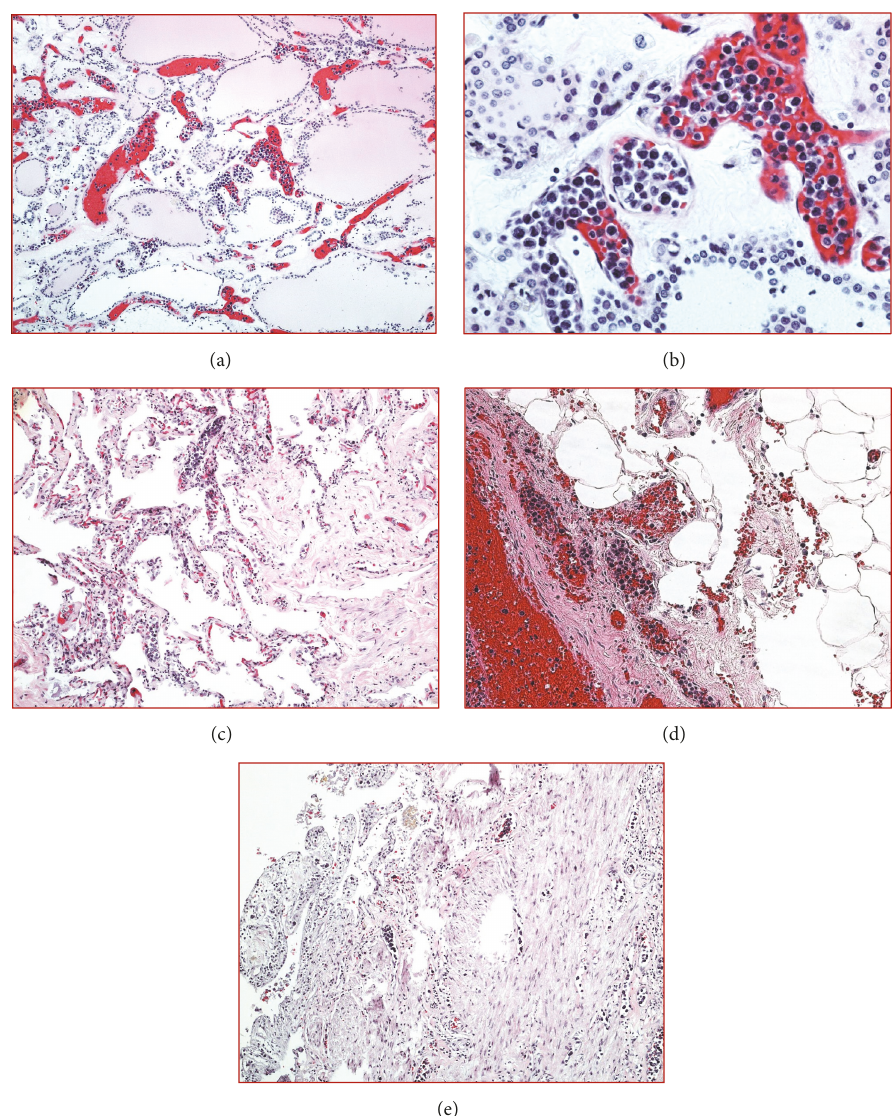
Figure 1: H&E. Large neoplastic lymphoid cells with hyperchromatic nuclei and coarse chromatin are present within the small blood vessels in thyroid ((a), 10X; (b), 40X), lung ((c), 10X), omentum ((d), 20X), and gall bladder ((e),